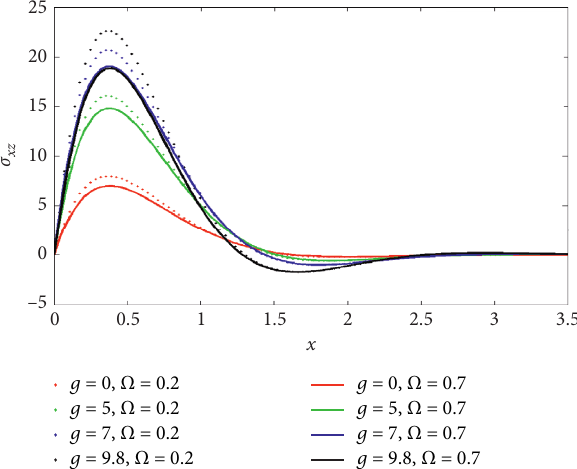
Figure 14: Stress σ x under gravity and rotation. xz concerning